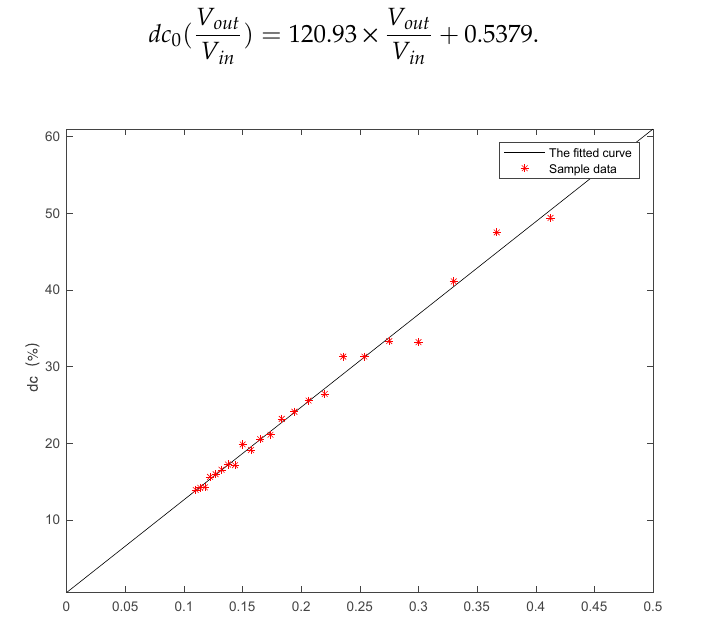
Figure 8. The curve of duty cycle dc 0 under different value of V out / V in .